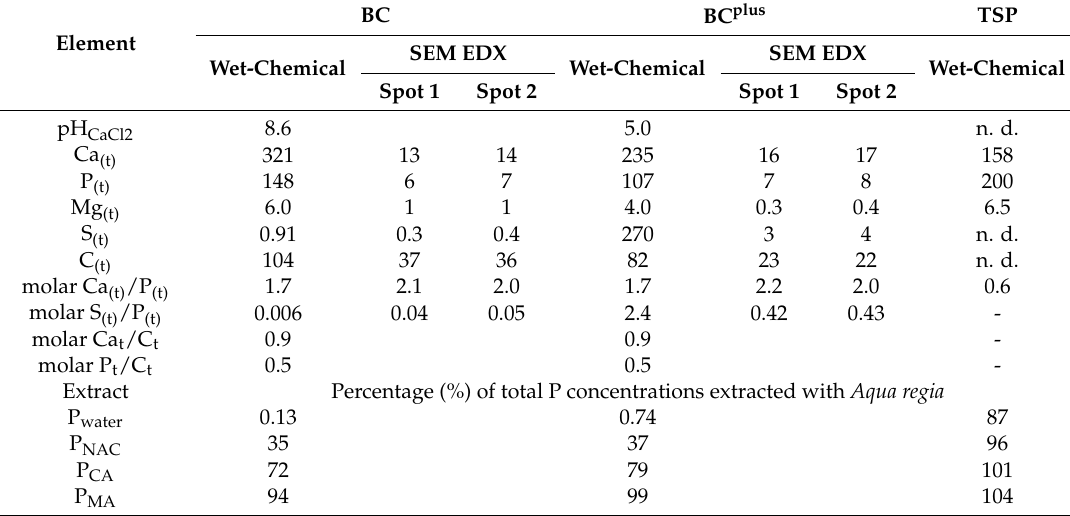
Table 1. Total elemental concentrations; Ca t , P t and Mg t from Aqua regia extract measured by ICP-OES, in g kg − 1 and S t , C t measured by CNS Analyzer. Atom percentage (%) of Ca, P, Mg, S and C in 2 spots measured by SEM-EDX, molar ratios of Ca (t) /P (t) , S (t) /P (t) , Ca t /C t , P t /C t , and pH values in CaCl 2 of bone char (BC), S-enriched bone char (BC plus ) and triple superphosphate (TSP) and proportions of P in water, neutral ammonium citrate (NAC), citric acid (CA) and mineral acid (MA) extract of the BC, BC plus and TSP in percentage (%) of total P concentrations extracted with Aqua regia